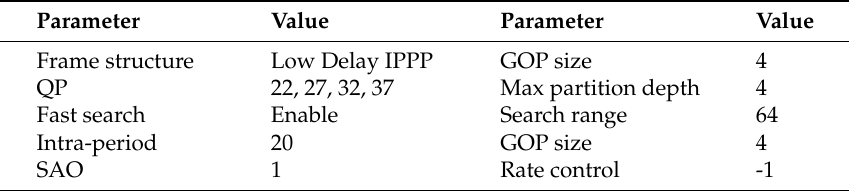
Table 1. Experimental configuration of